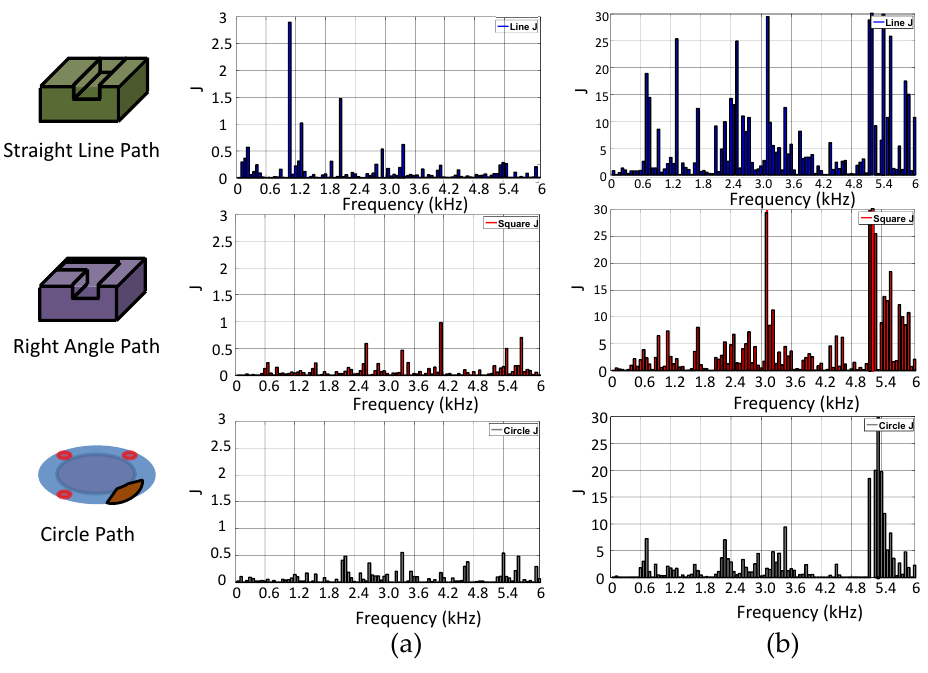
Figure 13. Scatter index J with various signal lengths: ( a ) 0.017 s; ( b ) 2.27 s.